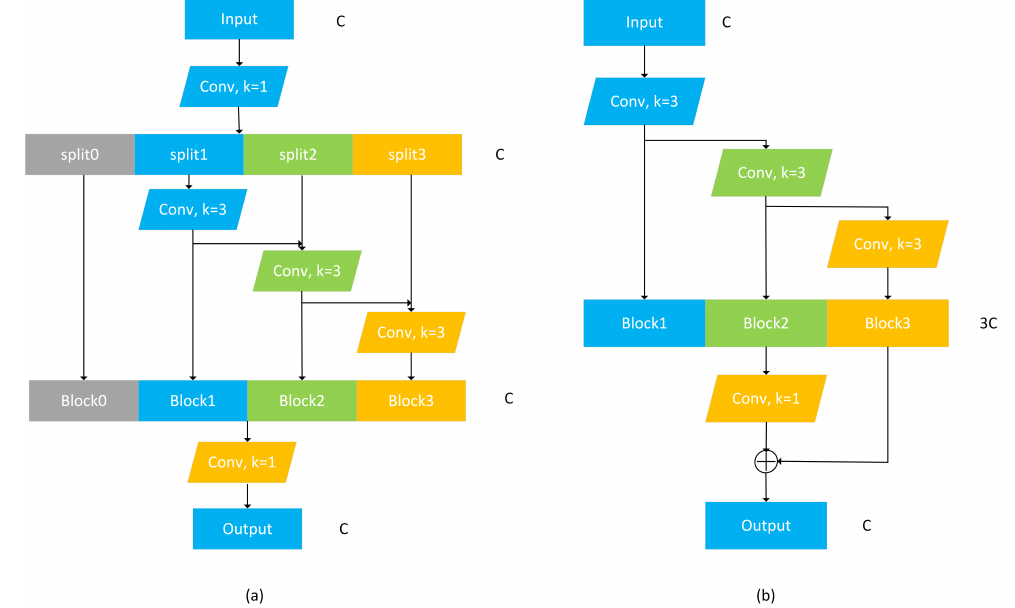
Figure 4. The structure diagram of the Res2Net module ( a ) and the MRFF module ( b ), the number on the right side of the feature map indicates the number of